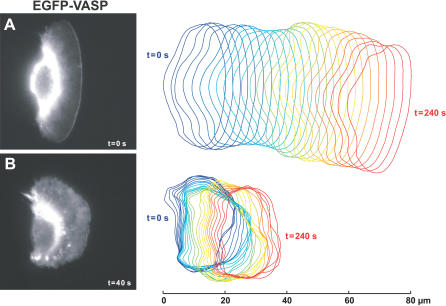
Smooth, Canoe-Shaped Keratocytes Migrate “Coherently,” with Fast Speeds and Persistent ShapesOutlines of migrating keratocytes overexpressing EGFP-VASP were generated from each frame of time-lapse image sequences separated by 10 s to examine the shape of cells as they migrate. Outlines are colored from blue to red to represent time (0–240 s), superimposed, and plotted on the same scale for visual comparison. Speed can be estimated from the distances traveled by each keratocyte because outlines correspond to the same total time. Fluorescent images correspond to the first (A) and fifth (B) frames of each time-lapse sequence and are scaled to match to the outlines. (A) The leading edge and overall shape of a smooth, coherent keratocyte does not vary extensively as the cell migrates. (B) In the case of a rough and rounder keratocyte, outlines show that the leading edge changes shape rapidly and widely. This keratocyte is unable to maintain persistent coordinated protrusion of its lamellipodium. Specific segments of the leading edge extend forward while adjacent regions lag behind (notice blue and orange outlines). This keratocyte migrates at approximately half the speed of the coherent keratocyte in (A).